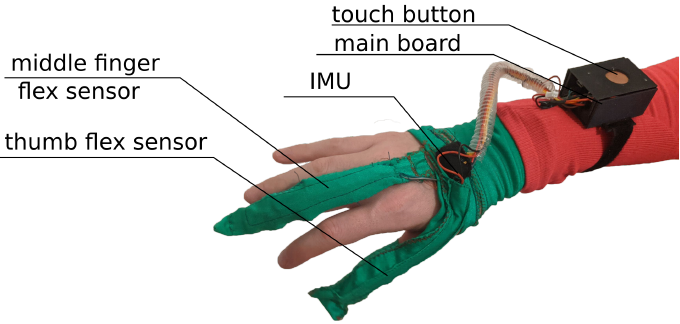
Figure 1. The prototype version of the